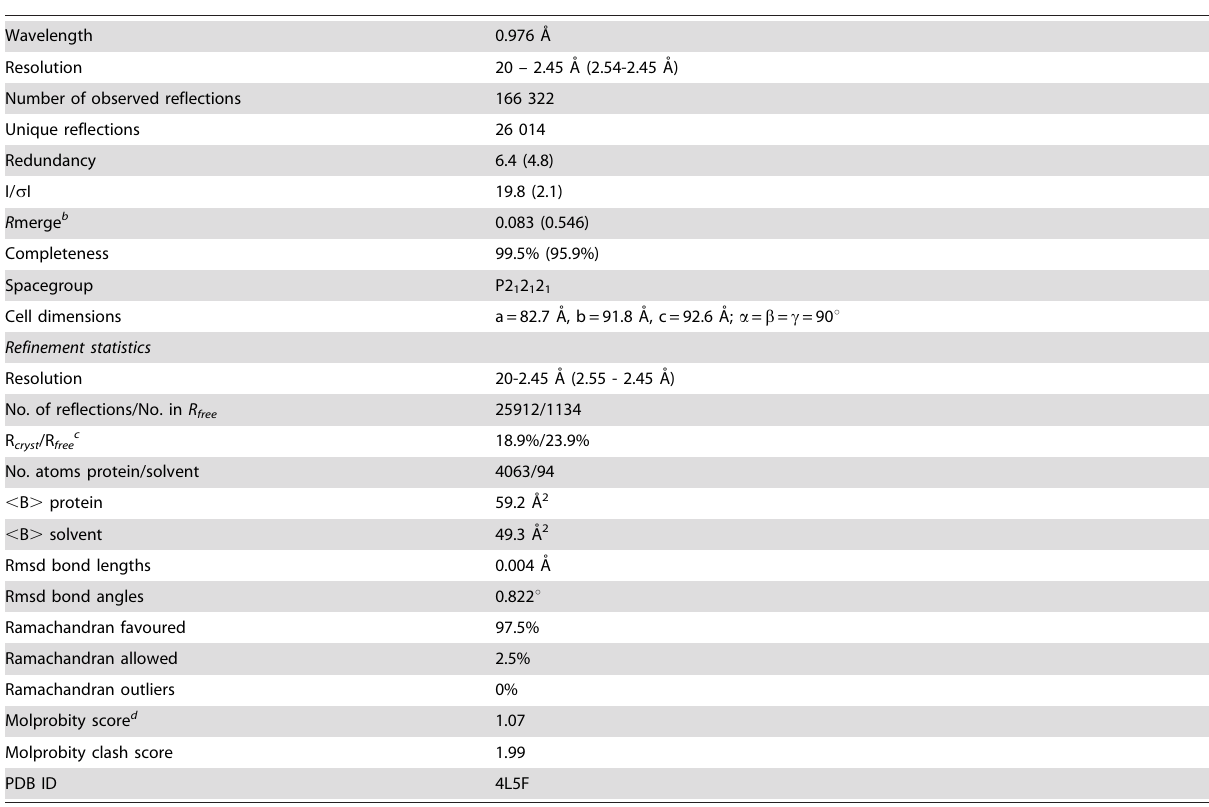
Table 1. Data collection and refinement statistics a .